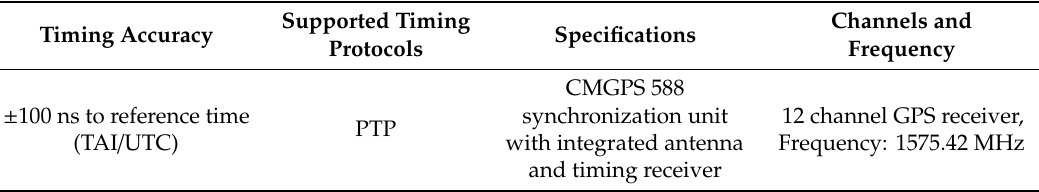
Table 1. GPS data sheet and timing